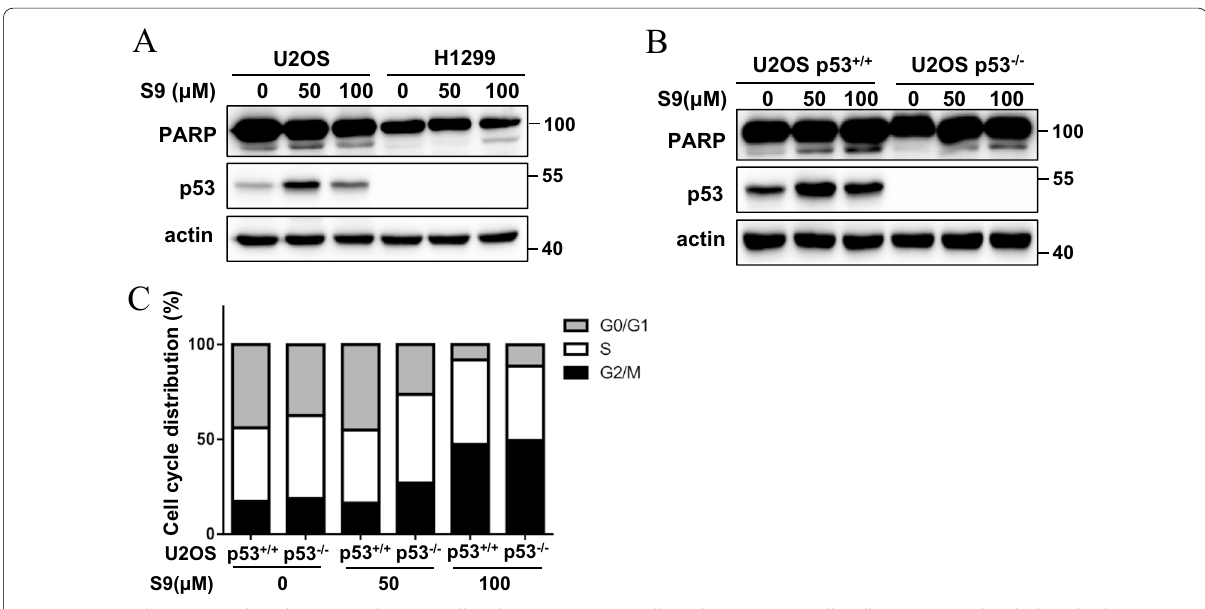
Fig. 6 p53 involves in S9-induced apoptosis but not cell cycle arrest. A U2OS cells and H1299 (p53 null) cells were treated with described concentration of S9 for 24 h. PARP and p53 protein levels were detected by western blot analysis. B , C U2OS p53 + / + and p53 − / − cells were treated with described concentration of S9 for 24 h. PARP and p53 protein levels were detected by western blot analysis ( B ); stained with PI and analyzed by flow cytometry ( C